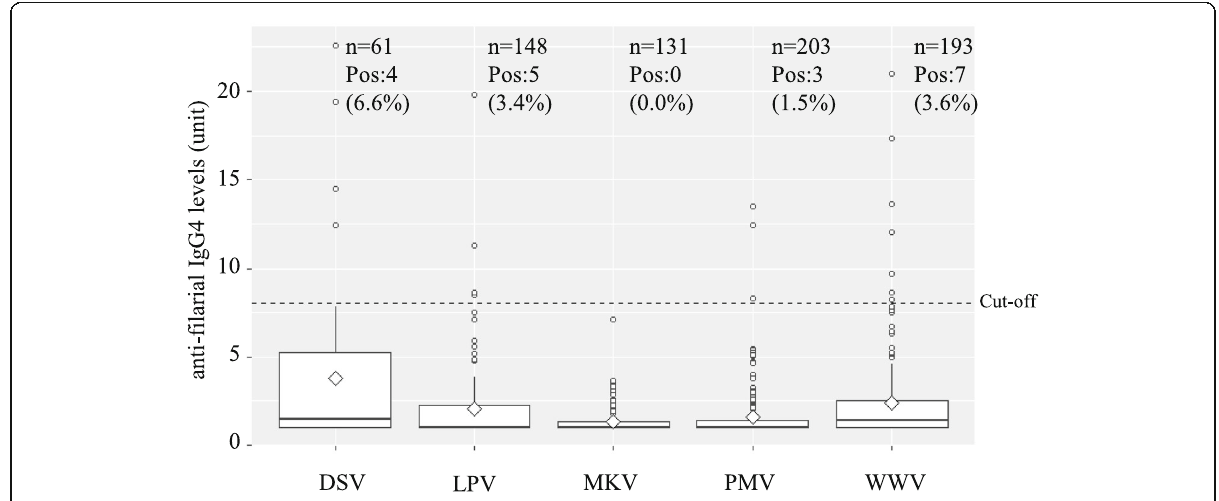
Fig. 2 Anti-filarial IgG4 levels of schoolchildren from five schools surveyed. Date shows that the anti-filarial IgG4 antibody levels in urine of schoolchildren belonging to each school (DSV, LPV, MKV, PMV, WWW). Total number of schoolchildren ( n ), number of anti-filarial IgG4 positives (Pos), and mean (white diamond), median (horizontal bar) were indicated. The dash line indicates the cut off value (7.08